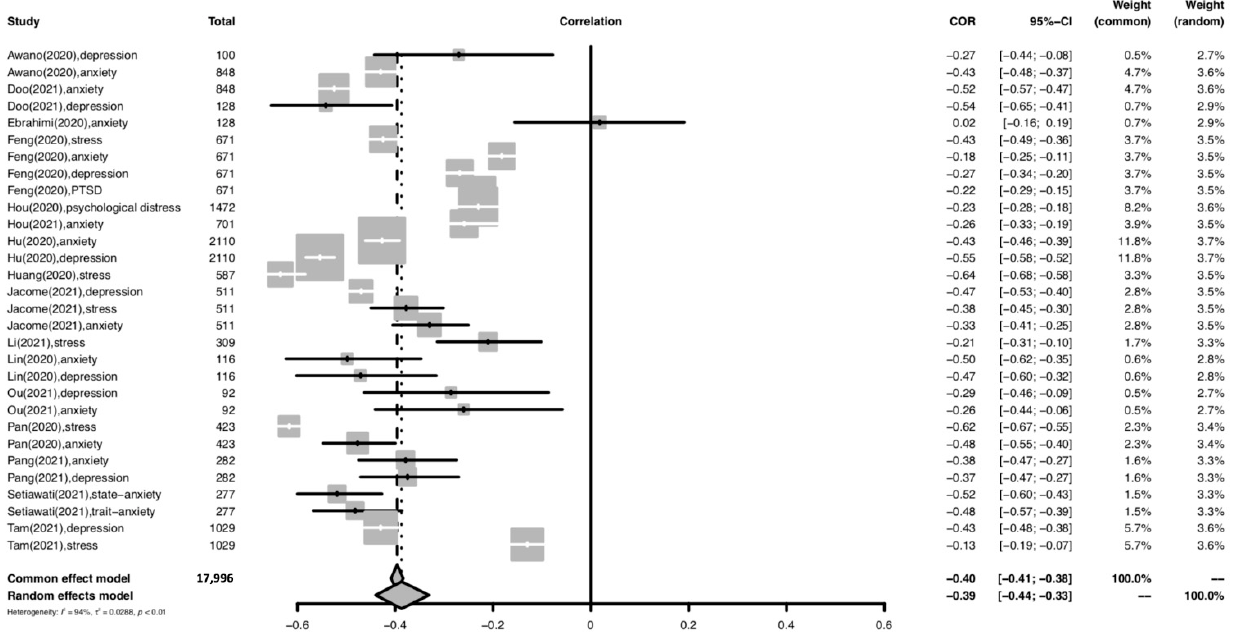
Figure 2. Forest plot of the relationship between resilience and psychological distress among healthcare workers. Abbreviation: COR, correlation coefficient; CI, confidence interval; I 2 , indicator of statistical heterogeneity; p , p -value; τ 2 , indicator of statistical heterogeneity. Horizontal lines indicate the 95% CI of each study; diamonds indicate the pooled estimate with a 95% CI.